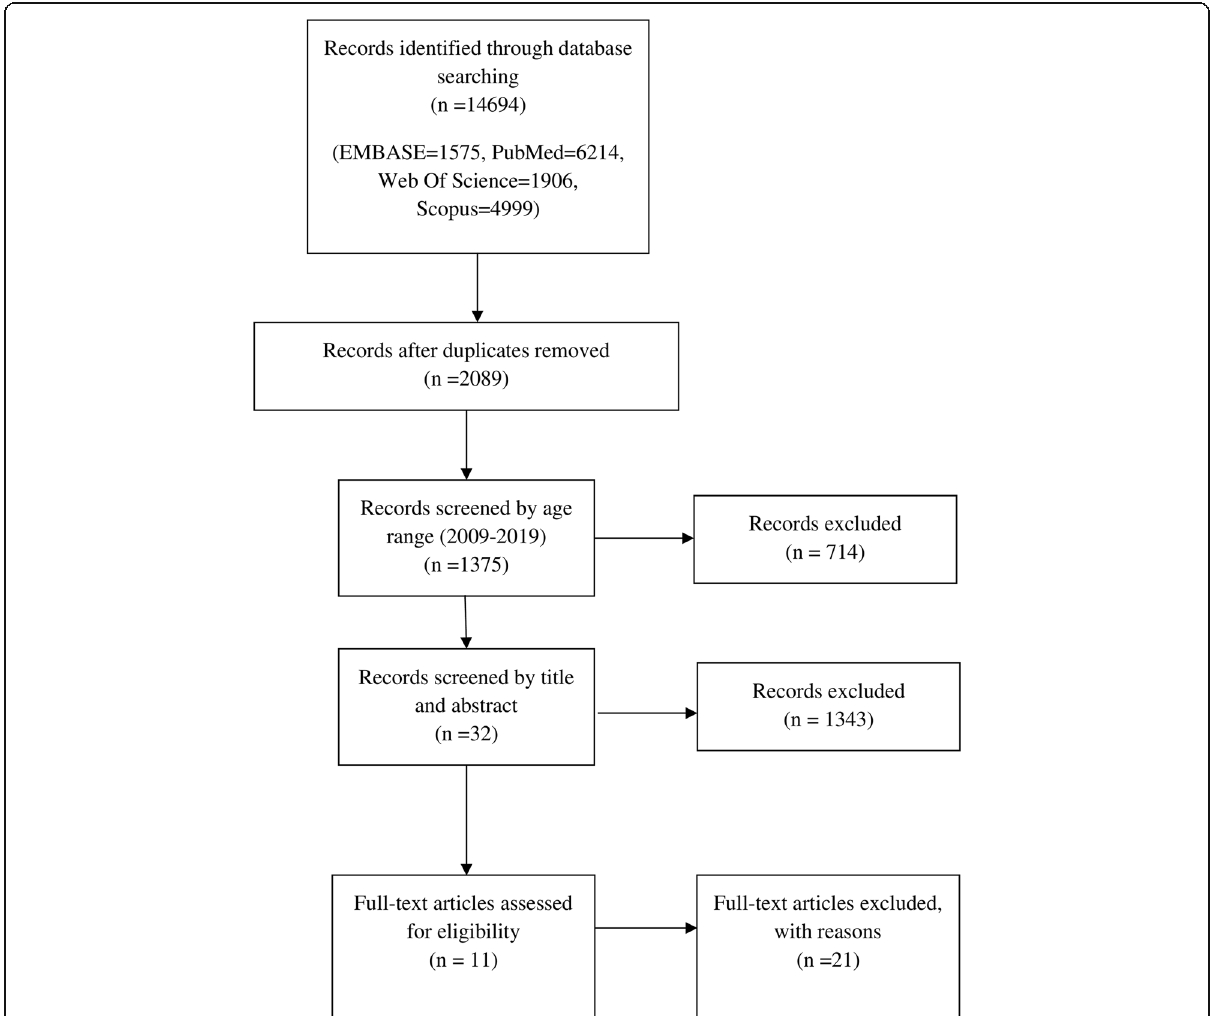
Fig. 1 Conducted study search